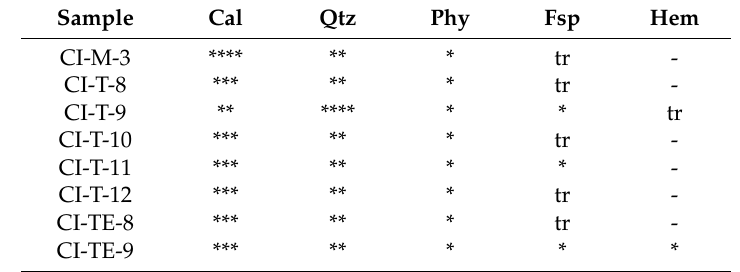
Table 2. Results of mineralogical composition of bulk mortar determined by X-ray diffraction.